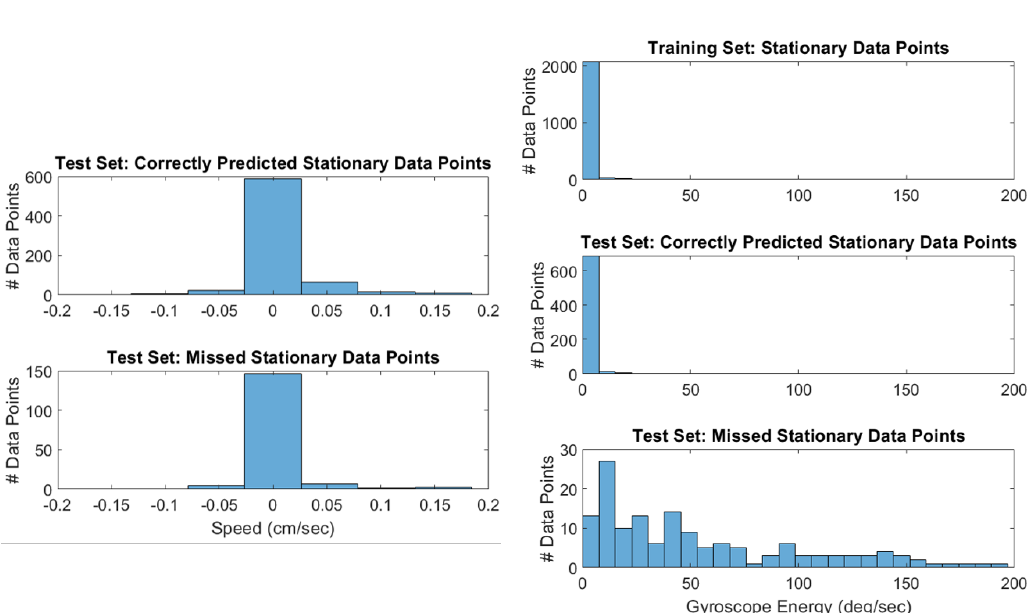
Figure 13. Missed Stationary Samples: ( Top Left Plot ) Ground truth speeds for samples falsely flagged as moving. Bins have widths of 0.04 cm/s. ( Bottom Left Plot ) Ground truth speeds for samples falsely flagged as moving. ( Top Right Plot ) Gyroscope energy in stationary samples for training data. Bins have width of approximately 7.6 deg/s. ( Middle Right Plot ) Gyroscope energy in correctly predicted stationary samples. ( Bottom Right Plot ) Gyroscope energy in missed stationary samples. This